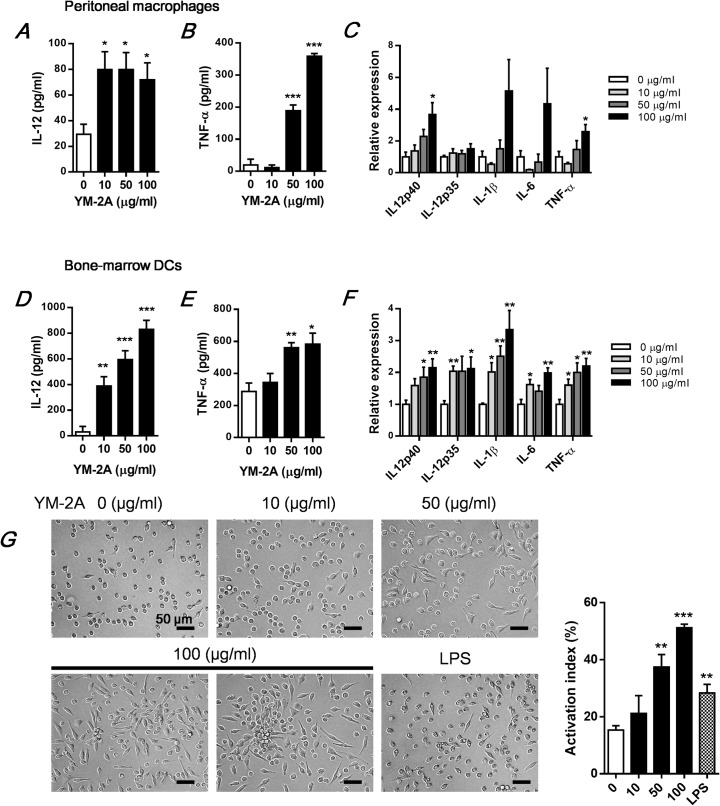
YM-2A increases various cytokine production from macrophages and DCs.Peritoneal macrophages (A-C), and bone marrow DCs (D-F) were incubated with YM-2A for 24 h. After incubation, TNF-α or IL-12 levels in the collected supernatants were measured by ELISA (A, B, D and E) and mRNA expression levels of cytokines were determined by real-time PCR (C and F). The relative expression level was normalized to the expression level with 0 μg/ml control. (G) Morphological change in macrophage. Morphology of macrophage visualized by optical microscopy (×400) (G, left panels). The activation index percentage was expressed as the number of cells with activated morphology relative to the total number of cells, quantified in 3–4 random fields (number of total cells >100) (G, right panels). The data presented are representative of two independent experiments. *p < 0.05, **p < 0.01 and ***p < 0.001, compared with 0 μg/ml control.